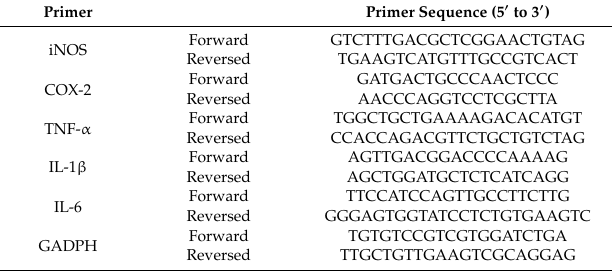
Table 3. Primer sequences in this